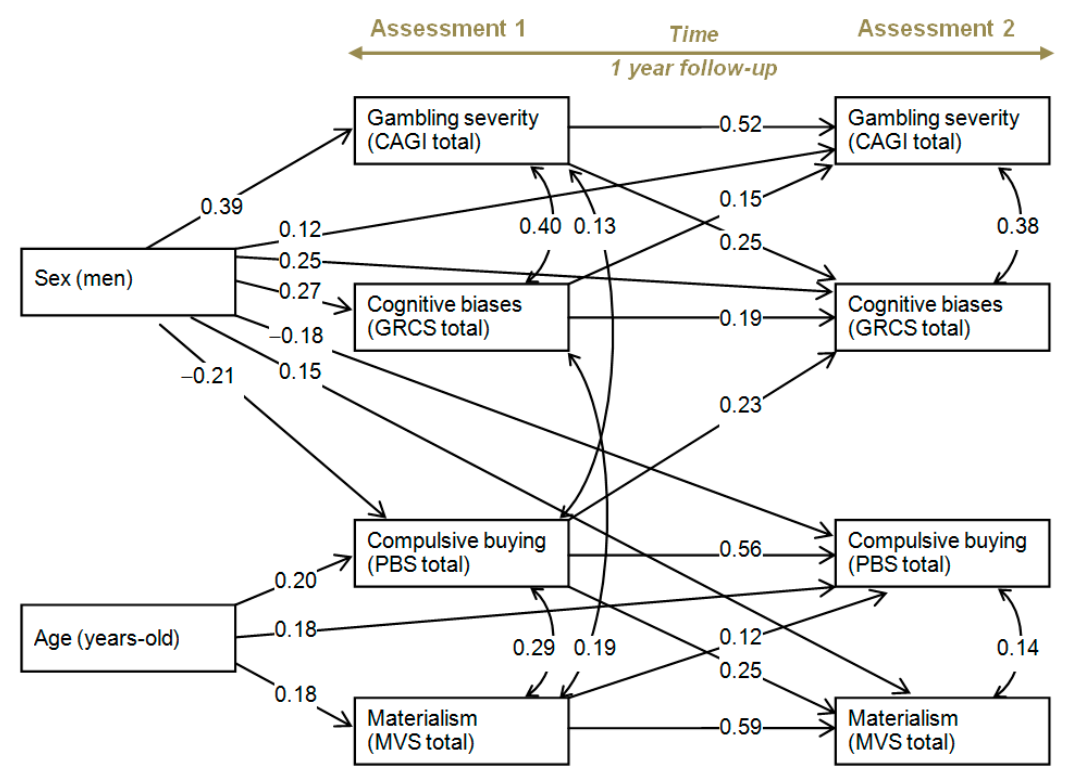
Figure 3. Path diagram with the standardized coefficients. Note. Only significant coefficients were retained in the model. Sample size: n = 182. GD: gambling disorder. CAGI: Canadian Adolescent Gambling Inventory. GRCS: Gambling-Related Cognitions Scale. PBS: Pathological Buying Screener. MVS: Materialism Values Scale.